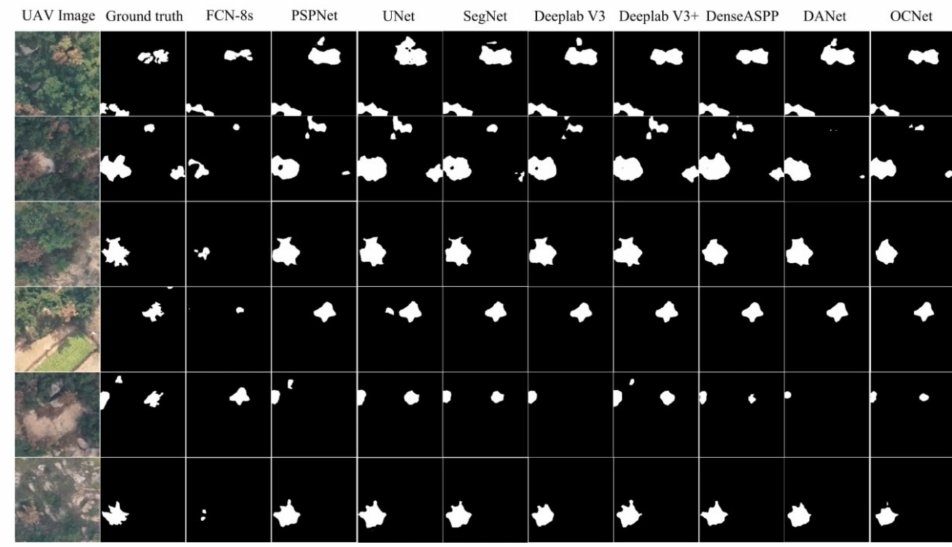
Figure 4. Segmentation results of models using Dice loss.